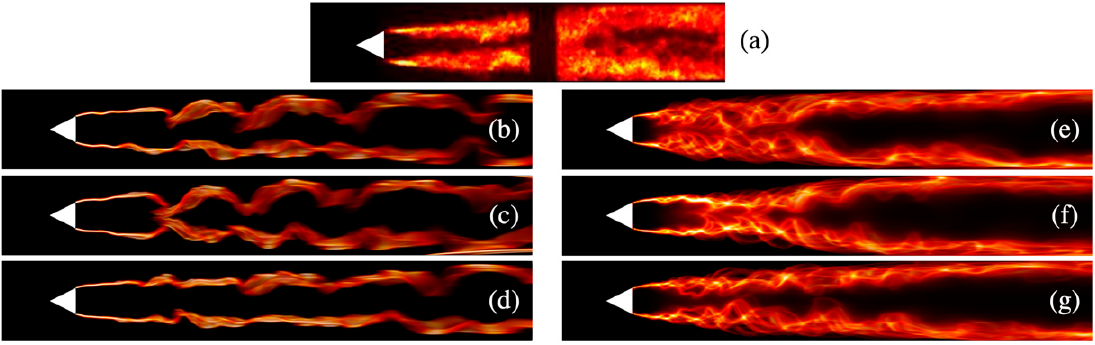
profile shapes are similar, with the